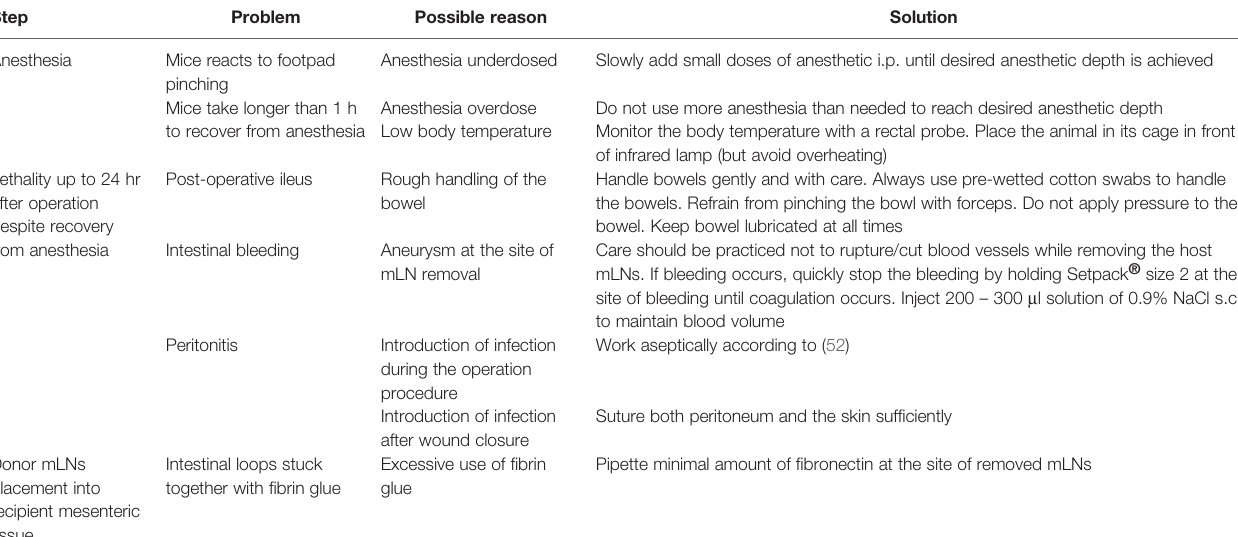
TABLE 2 | Troubleshooting guide. Step